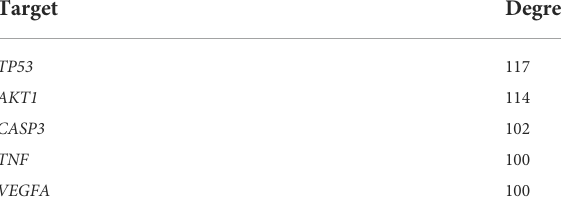
TABLE 5 Degree of the key target of botanical drugs